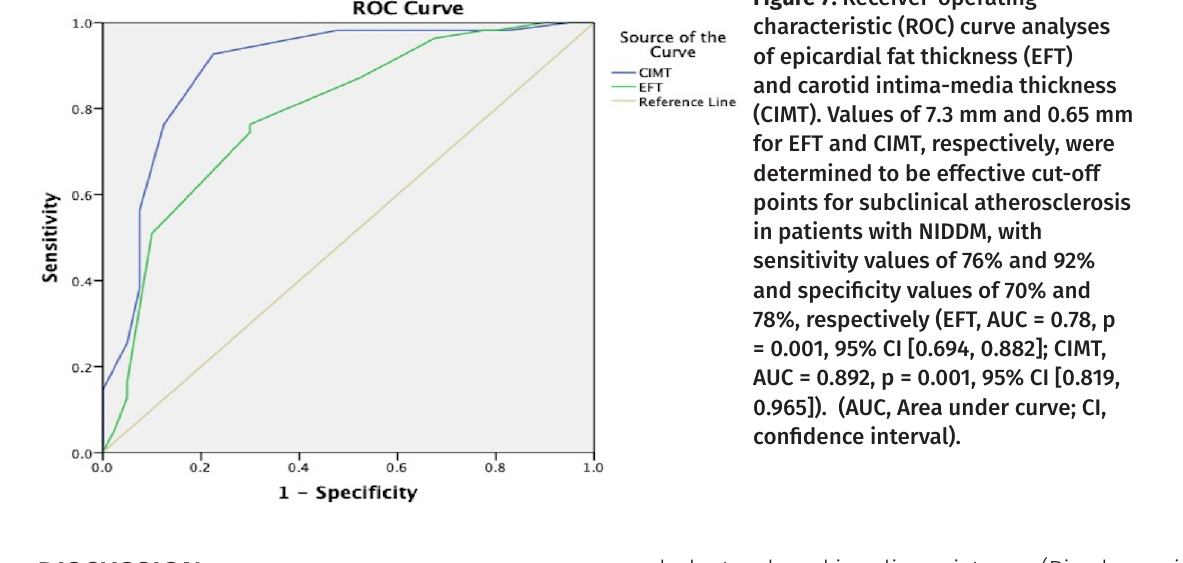
Figure 7. Receiver-operating characteristic (ROC) curve analyses of epicardial fat thickness (EFT) and carotid intima-media thickness (CIMT). Values of 7.3 mm and 0.65 mm for EFT and CIMT, respectively, were determined to be effective cut-off points for subclinical atherosclerosis in patients with NIDDM, with sensitivity values of 76% and 92% and specificity values of 70% and 78%, respectively (EFT, AUC = 0.78, p = 0.001, 95% CI [0.694, 0.882]; CIMT, AUC = 0.892, p = 0.001, 95% CI [0.819, 0.965]). (AUC, Area under curve; CI, confidence